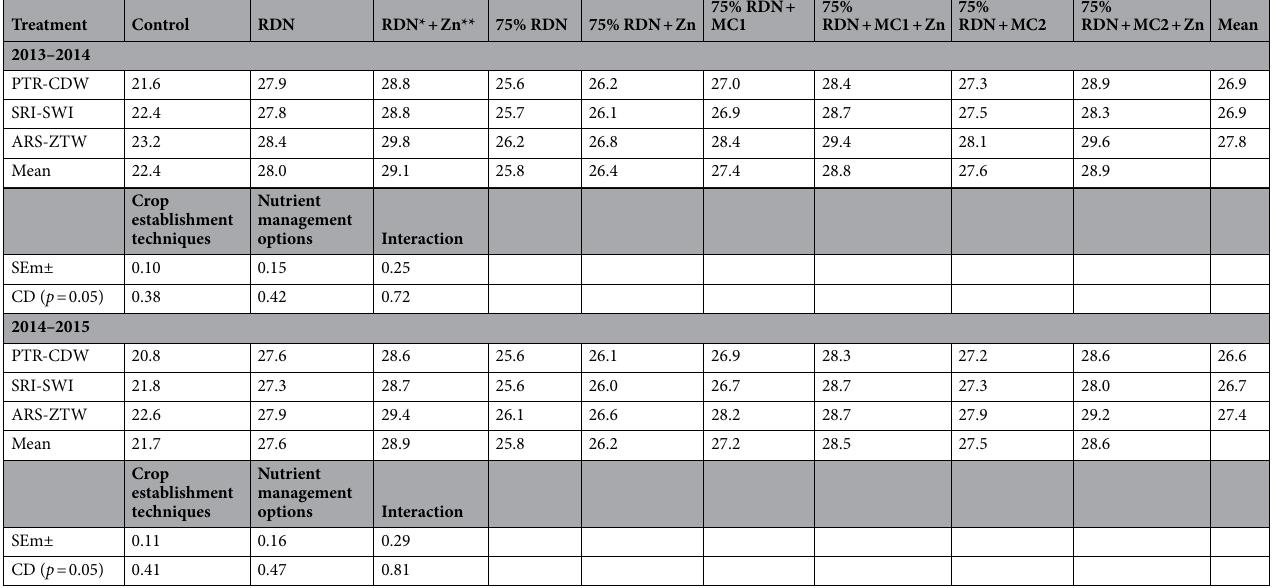
Table 3. Influence of crop establishment techniques and nutrient management options on phosphorus uptake (kg P ha −1 ) in rice–wheat cropping system during 2013–2014 and 2014–2015. PTR , puddled transplanted rice; SRI , system of rice intensification; ARS , aerobic rice system; CDW , conventional drill-sown wheat; SWI , system of wheat intensification; ZTW , zero tillage wheat; RDN* , recommended dose of nutrients [120 kg nitrogen ha −1 and 25.8 kg phosphorus (P) ha −1 per crop]; Zn** , 5 kg Zn ha −1 through ZnSO 4 ·7H 2 O per crop; MC1 , Anabaena sp . (CR1) + Providencia sp . (PR3) consortium; MC2 , Anabaena – Pseudomonas biofilm; Potassium (K) was applied uniformly in all treatments @ 49.8 kg K ha −1 per crop; Interaction , significant in both cropping